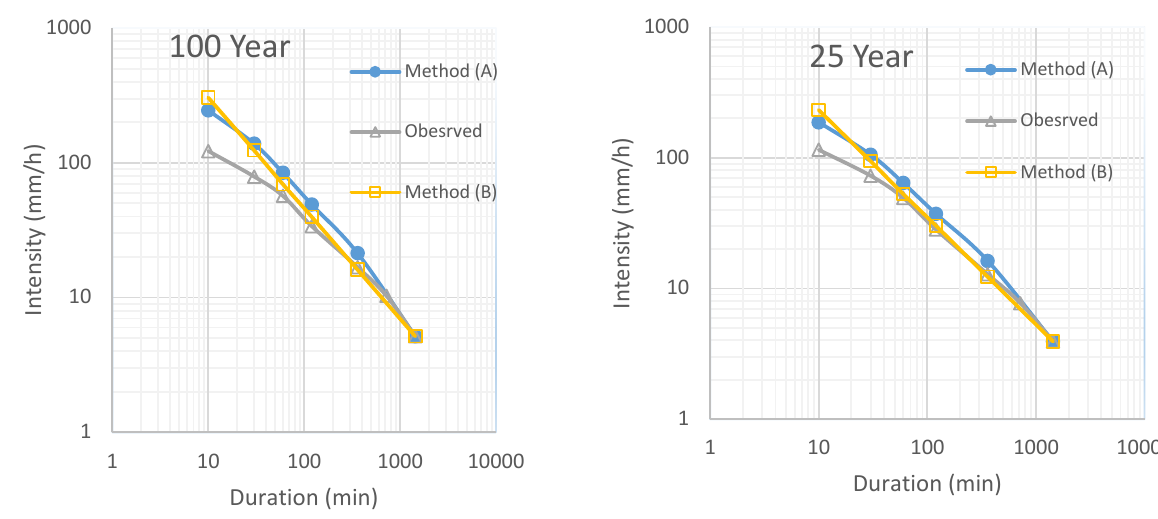
Figure 8. Comparison of IDF curves between two methods and observed with return periods 100 and 25 years using Log-Pearson type III distribution.